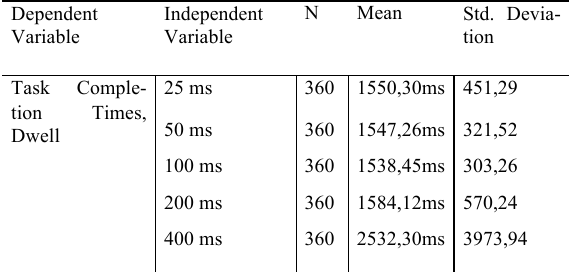
Descriptive Statistics for Task Completion Times for the Dwell Condition.